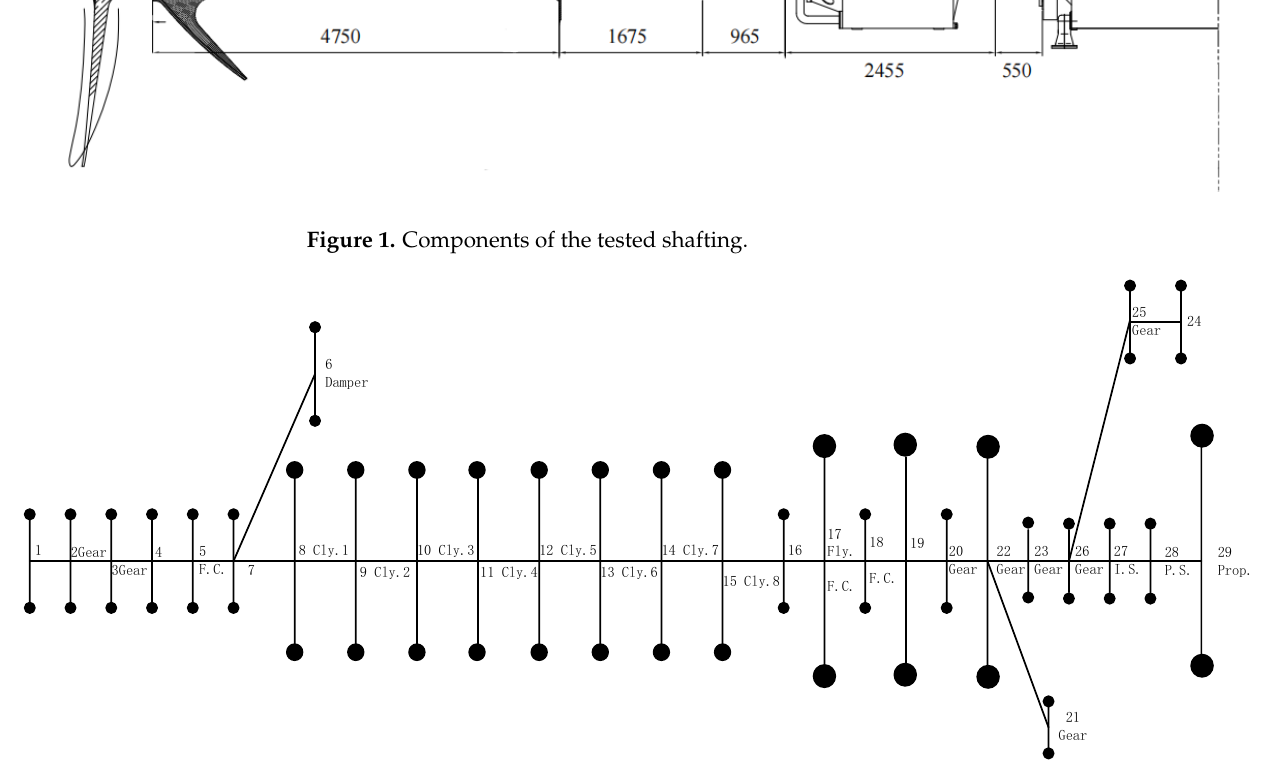
Figure 2. Simplified diagram of shafting equivalent system.